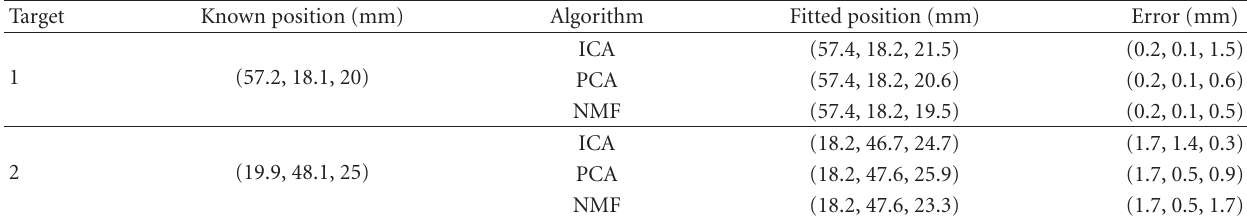
Table 2: Known positions versus retrieved positions of the absorptive targets using ICA, PCA, and NMF algorithms.